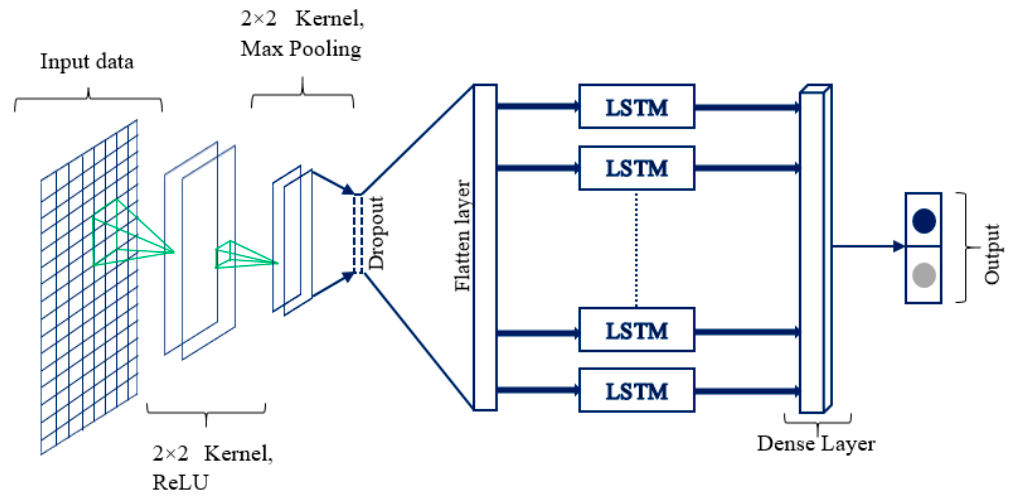
Figure 6. Proposed convolutional neural network based LSTM (CNN-LSTM) model.